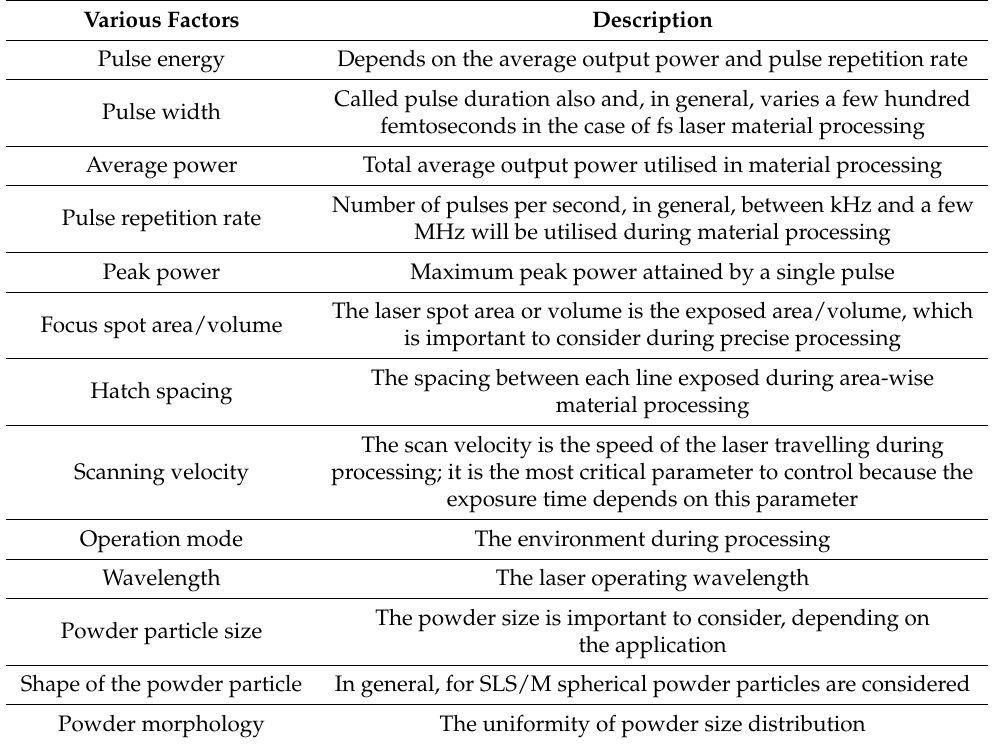
Figure 3. Energy penetration (red) and volume heated via heat conduction (yellow) or different pulse durations [47]. Table 5. Various factors that influence fs laser material processing